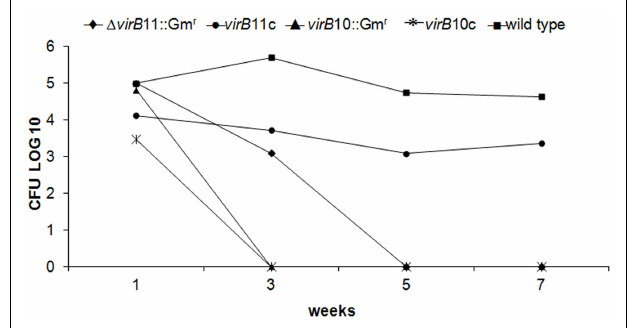
FIGURE 1 |Virulence in mice. Mice were infected i.p. with 1.4 × 10 8 CFU of B. canis wild-type strain, the virB10 and virB11 mutants or the virB- complemented mutant strains, and the numbers of CFU recovered from spleens at different times post-infection were determined as described in the Section “Materials and Methods”. (cid:2) B. canis Δ virB 11::Gm r ; • B. canis virB 11::Gm (cid:3) B. canis virB 10::Gm r ; ∗ B. canis c ; virB 10::Gm c ; (cid:4) B. canis wild type.